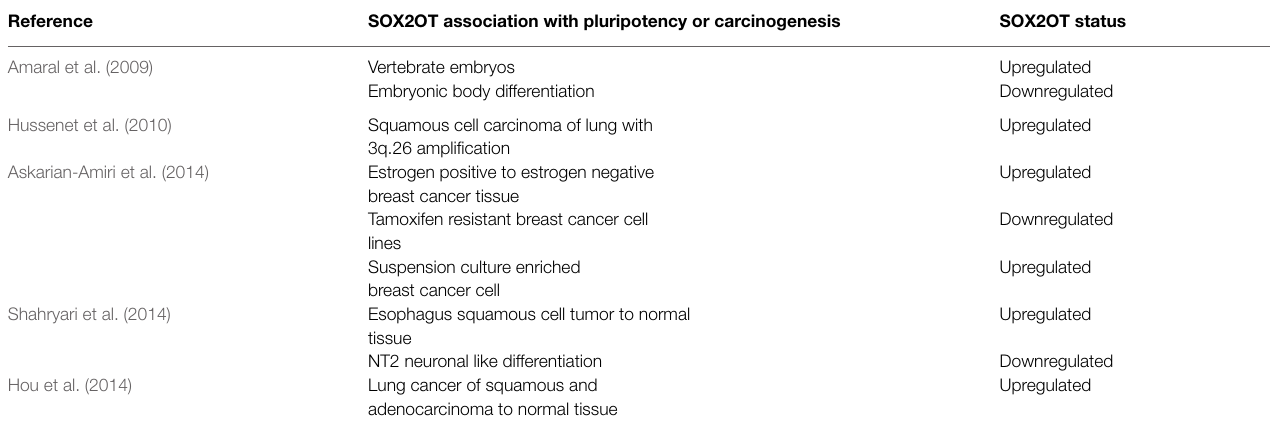
TABLE 1 | Recent studies which highlighted emerging roles of SOX2OT in pluripotency and